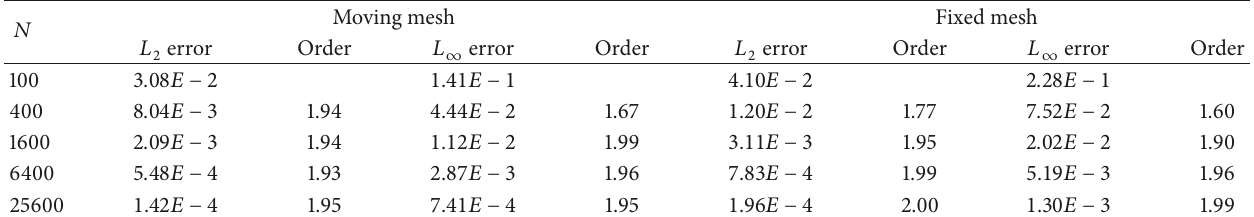
Table 2: Example 4. The numerical error and convergence order for the 2D BBM-Burgers equation. 𝑁 Moving mesh Fixed mesh 𝐿 2